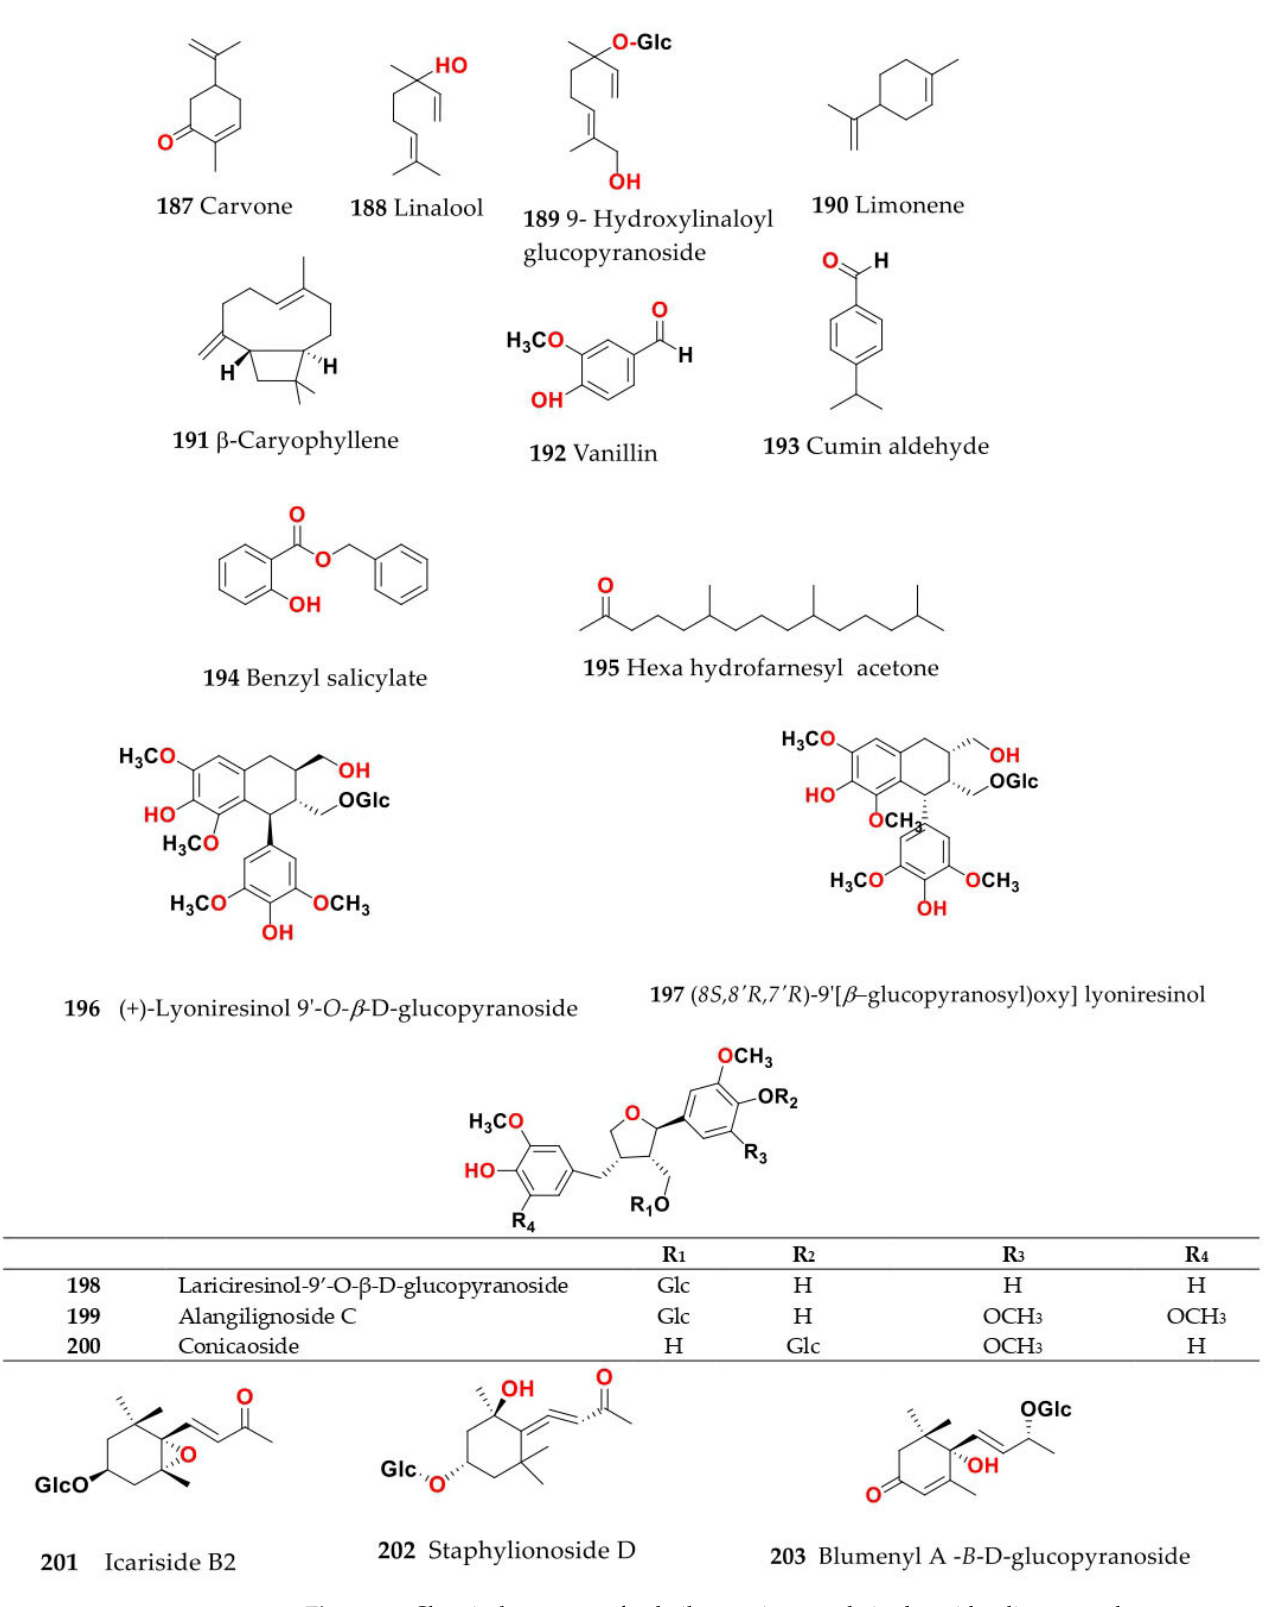
Figure 15. Chemical structure of volatile constituents, their glycosides, lignans and megastegmanes, isolated from genus Salsola.